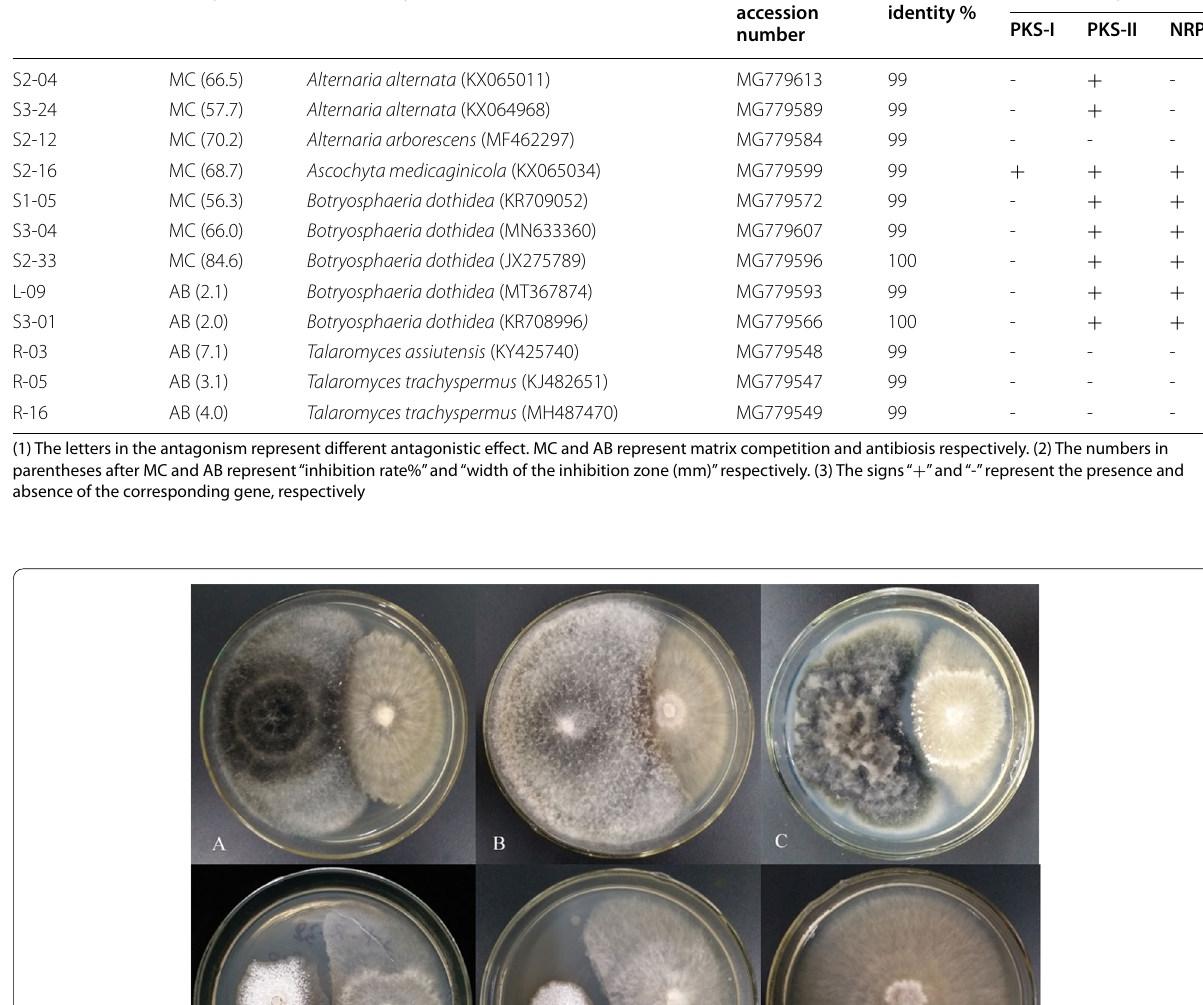
Table 1 Antagonism, ITS analysis, and detection of PKS/NRPS genes of twelve trains against Rhizoctonia cerealis